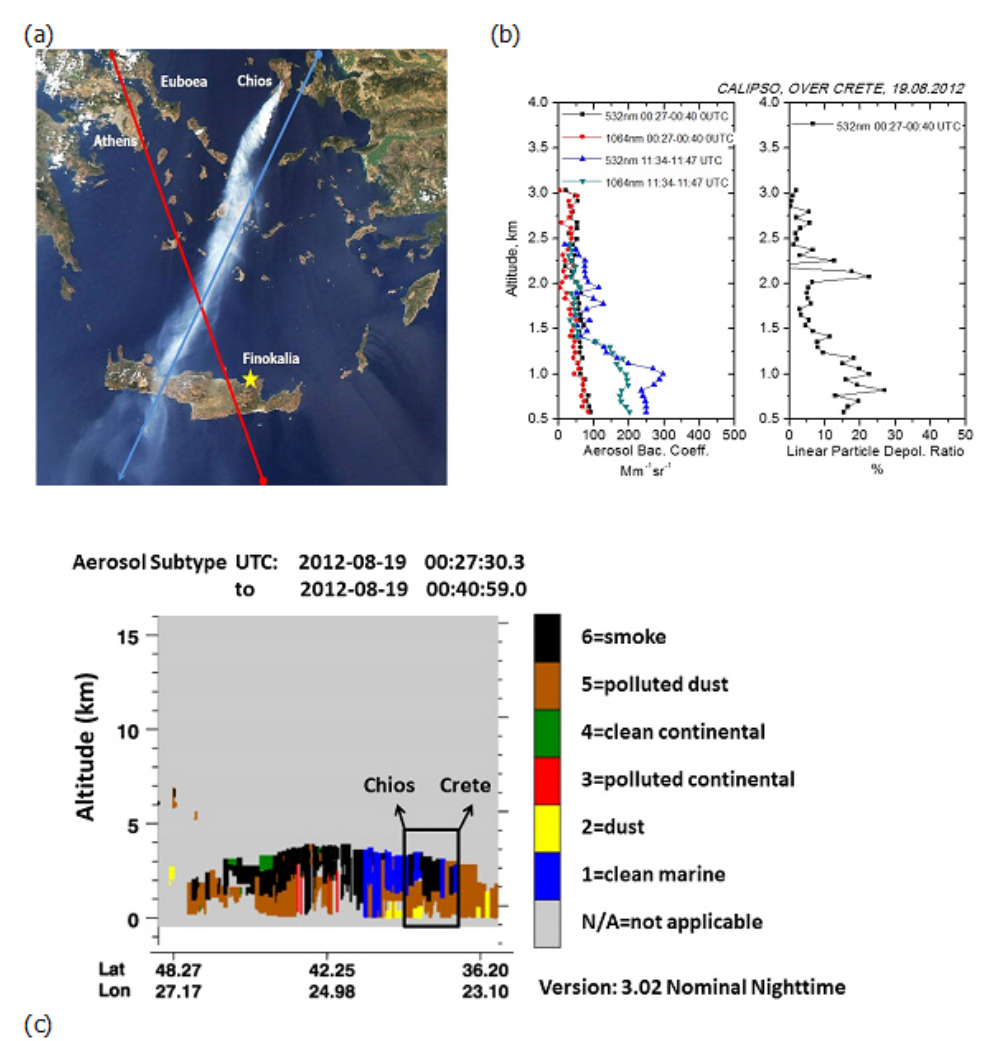
Figure 2. (a) Satellite composite view from MODIS of the fire plume emerging from the island of Chios on 18 August 2012 (courtesy of NASA). The blue and red lines delineate the two ground tracks of the CALIPSO satellite during its overpass over Crete on 19 August 2012 between 00:27–00:40 and 11:34–11:47UTC. (b) Vertical profiles of the aerosol backscatter coefficient (in km − 1 sr − 1 ) at 532 and 1064nm (left) and linear particle depolarization ratio at 532nm (right) measured by CALIPSO and (c) vertical profiles of the aerosol subtypes captured by CALIPSO during its overpass over Crete; the marked area is located at the NW of Finokalia station